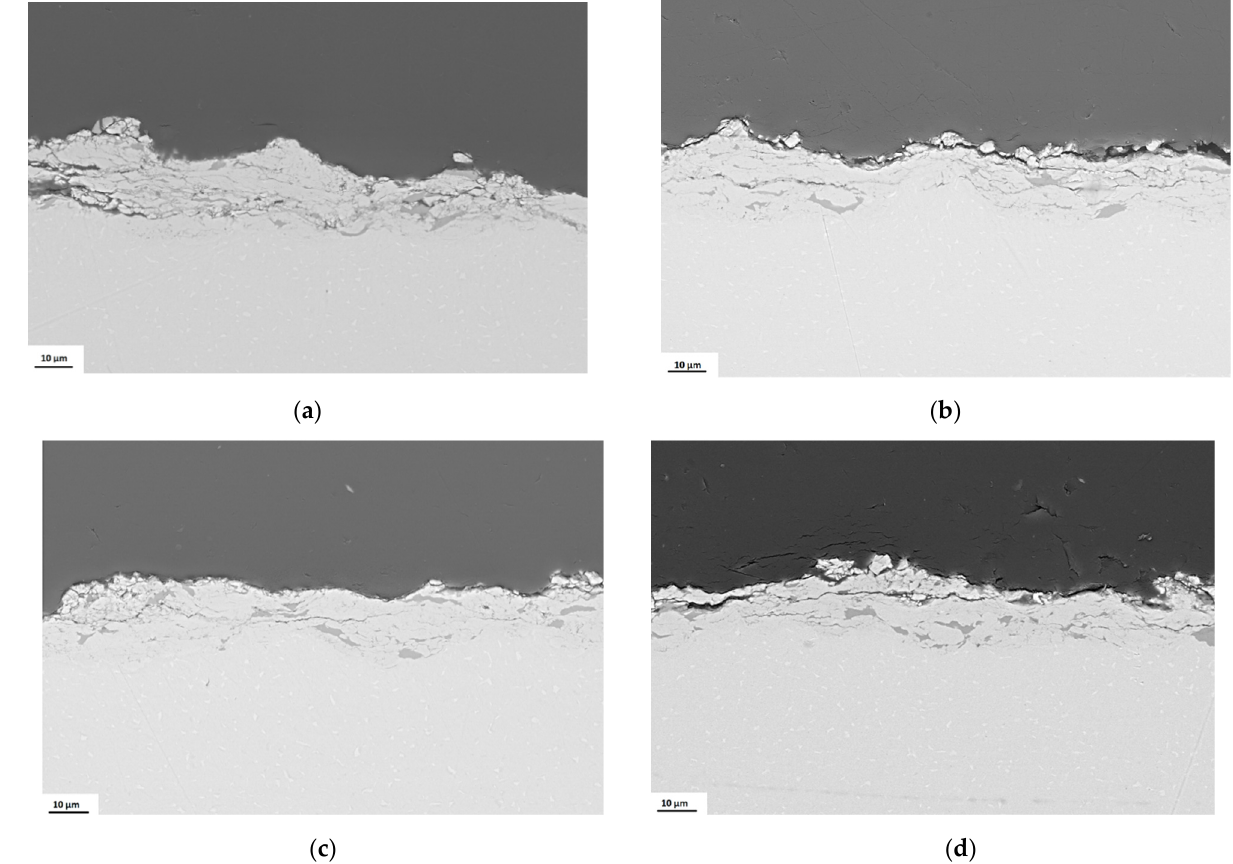
Figure 11. SEM micrographs of Ti 3 AlC 2 coating obtained at: ( a ) ~723 m/s; ( b ) 734 m/s; ( c ) 743 m/s; ( d ) 769 m/s on TA6V.